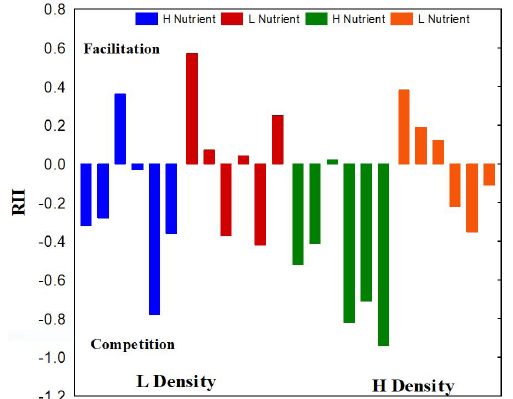
Figure 7. RII index demonstrating the ecological relationships between Alternanthera philoxeroides in relation to the density of the neighbor specie Polygonum ferrugineum and the availability of nutrients. Values: 0 indicates neutrality, < 0 indicates competition, and > 0